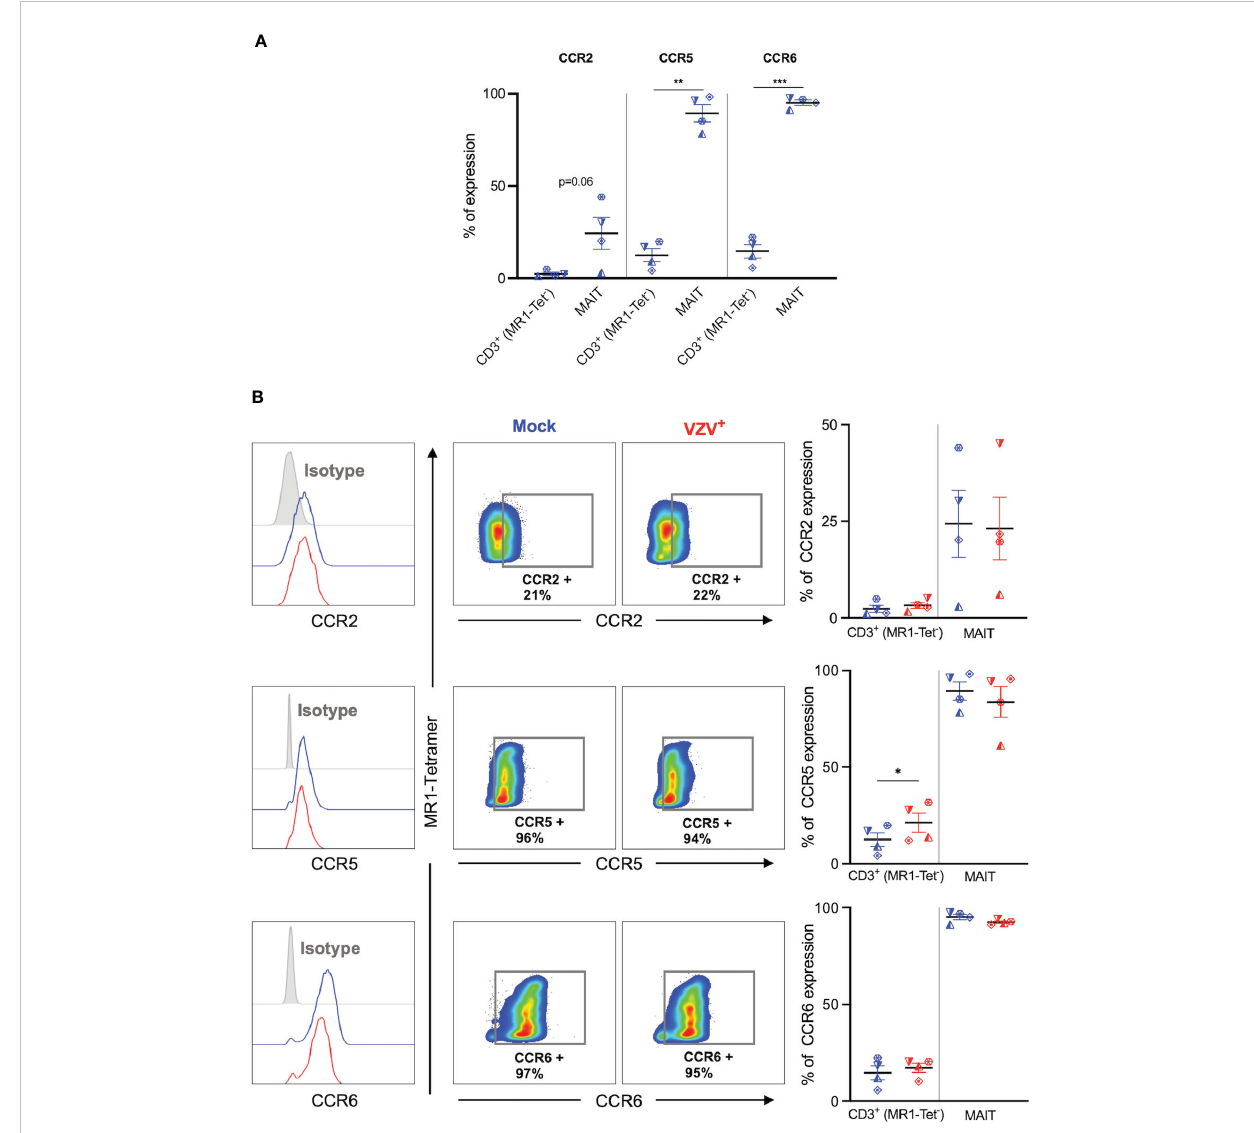
FIGURE 4 VZV infection of MAIT cells does not suppress CCR2, CCR5 and CCR6 expression. Human PBMCs were inoculated with mock or VZV-S infected ARPE-19 epithelial cells for 2 days and then analyzed for infection (gE:gI), and extravasation chemokine receptor markers (CCR2, CCR5 and CCR6) by fl ow cytometry. (A) Graph shows comparative frequency of surface CCR2, CCR5, and CCR6 expression in mock inoculated non-MAIT (ie MR1- Tet - ) CD3 + T cells and MAIT cell populations, with symbols representing individual donors (n=4). Statistical analysis was performed via two tailed paired t test. **p<0.001, ***p<0.001. (B) Representative histograms show expression of CCR2, CCR5 and CCR6 by MAIT cells for Mock (blue) and VZV infected (VZV + ) (red) populations corresponding to their respective isotype controls ( fi lled grey). Flow cytometry plots show surface expression of CCR2, CCR5 and CCR6 on mock infected (blue) and VZV infected (red) MAIT cell populations. Graphs show frequencies of non-MAIT CD3 + T cells and MAIT cells expressing CCR2, CCR5 and CCR6, with symbols representing individual donors, with mean and SEM indicated by the bars. Statistical analysis of CCR2, CCR5 and CCR6 expression between Mock and VZV + infected non-MAIT CD3 + cells and MAIT cells was performed via two tailed paired t test (n=4).